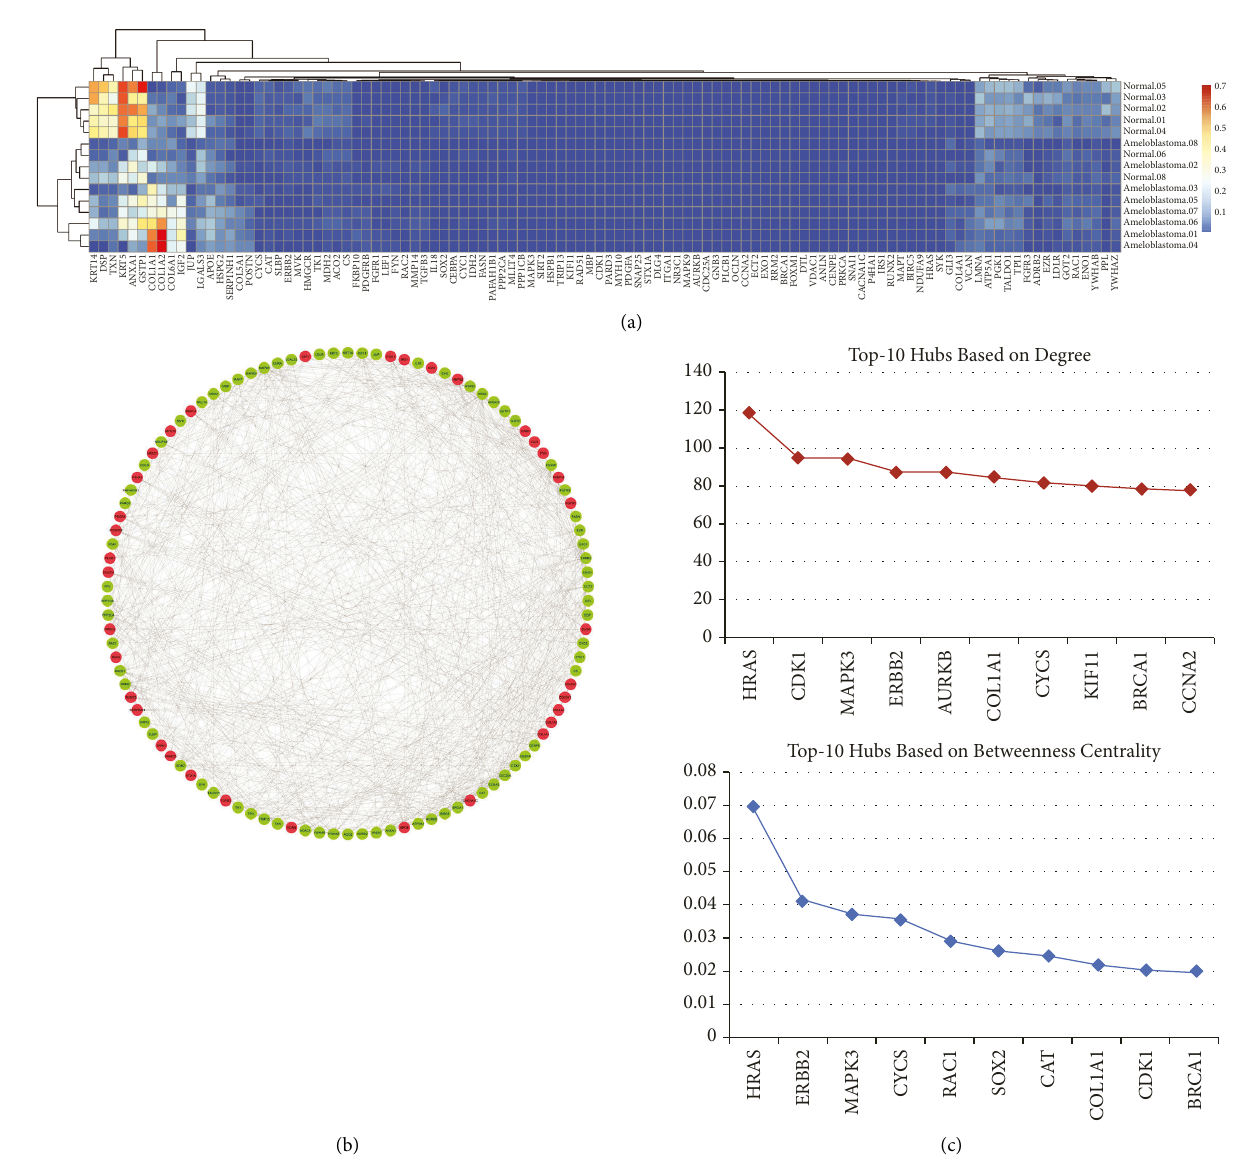
Figure 3: (a) The hierarchical clustering and heat-map of the hub genes. (b) Demonstrating the interaction between hub genes in the PPI network associated with the primary ameloblastoma. The red and green circles represent up- and downregulated genes in ameloblastoma, respectively. (c) Top-10 hub genes based on the degree (red diagram) and betweenness centrality (blue diagram). The x -axis and y -axis present the name of the gene and their corresponding centrality value, respectively. PPI, protein-protein